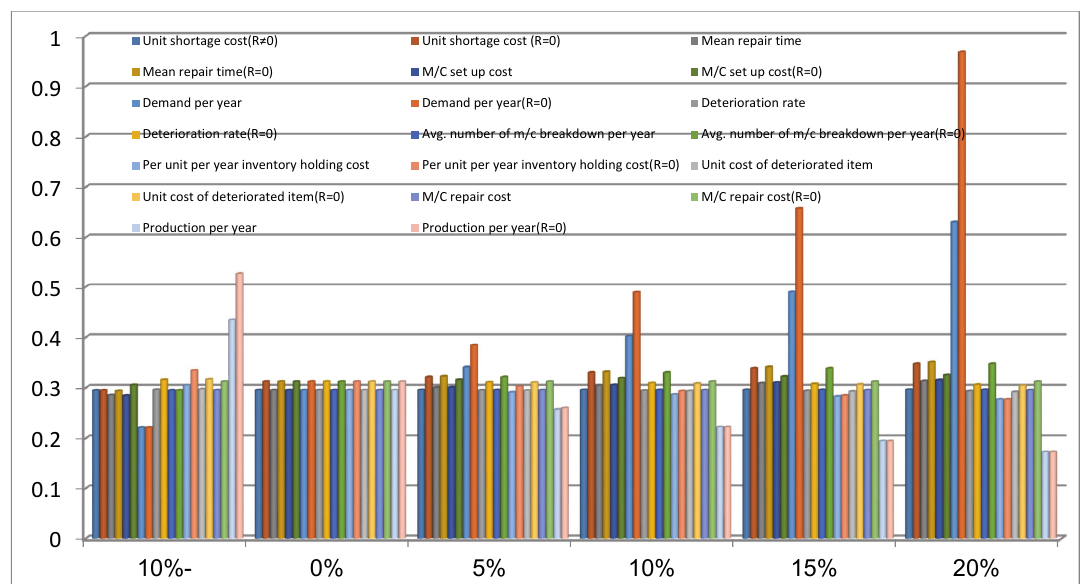
Fig. 17. Comparison of production uptime for percentage change of input